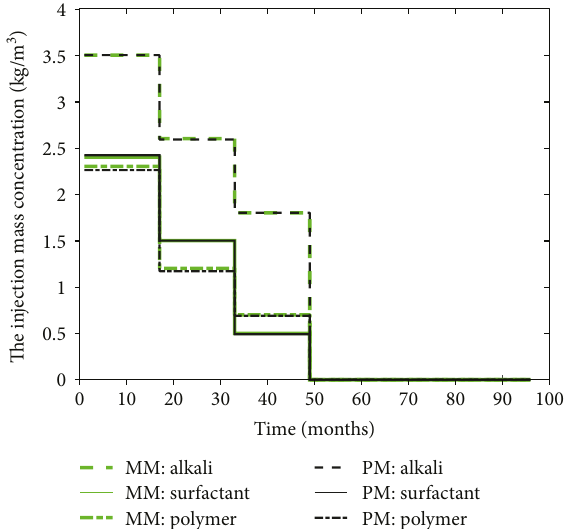
Figure 11: Comparison of the optimal injection